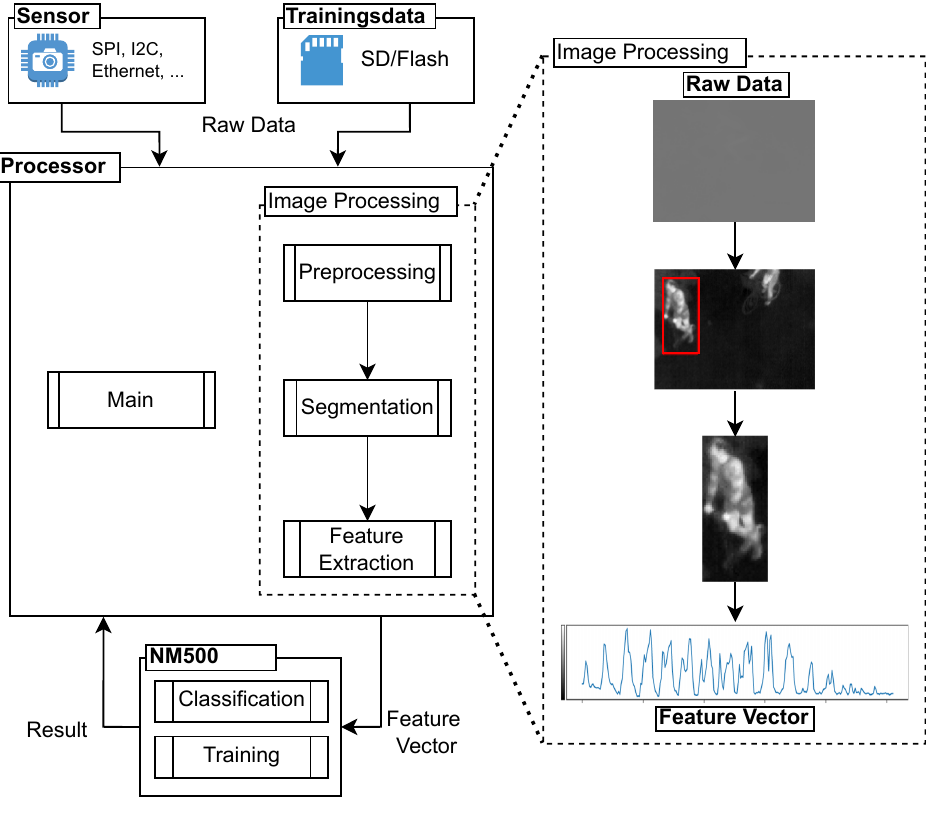
Figure 4. Conceptual data